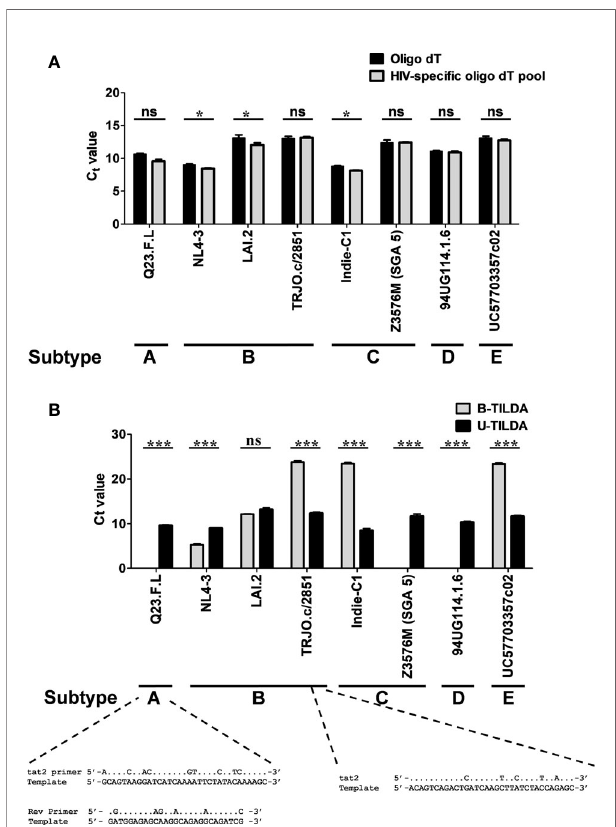
FIGURE 4 | The assay detects the diverse genetic subtypes of HIV-1 with comparable ef fi ciency. (A) The assay was performed using cDNA of the total RNA extracted from HEK293T cells transfected with one of the eight DNA plasmid vectors representing fi ve major HIV-1 genetic subtypes, as shown. The reverse transcription was performed using the generic oligo-dT ( fi lled bars) or a pool of three HIV-1-speci fi c oligo-dT primers (grey bars). Data are representative of two independent experiments performed in triplicates. The data are normalized against GAPDH transcripts and presented as Ct value Mean ± SD. Paired t -test was used for the statistical evaluation (*p<0.05, ***p<0.001, and ns – not signi fi cant). (B) B-TILDA is severely impacted by HIV-1 genetic diversity. Viral cDNA samples prepared as in panel A above were used to compare the performance of B-TILDA (grey bars) Vs. U-TILDA ( fi lled bars) formats. The data are normalized against GAPDH transcripts and presented as Ct value Mean ± SD. The sequence diversity of two viral strains with the B-TILDA primers has been presented where the assay failed (Q23.F.L) or the ampli fi cation ef fi ciency was profoundly compromised (TRJO.c/2851). The dots represent sequence